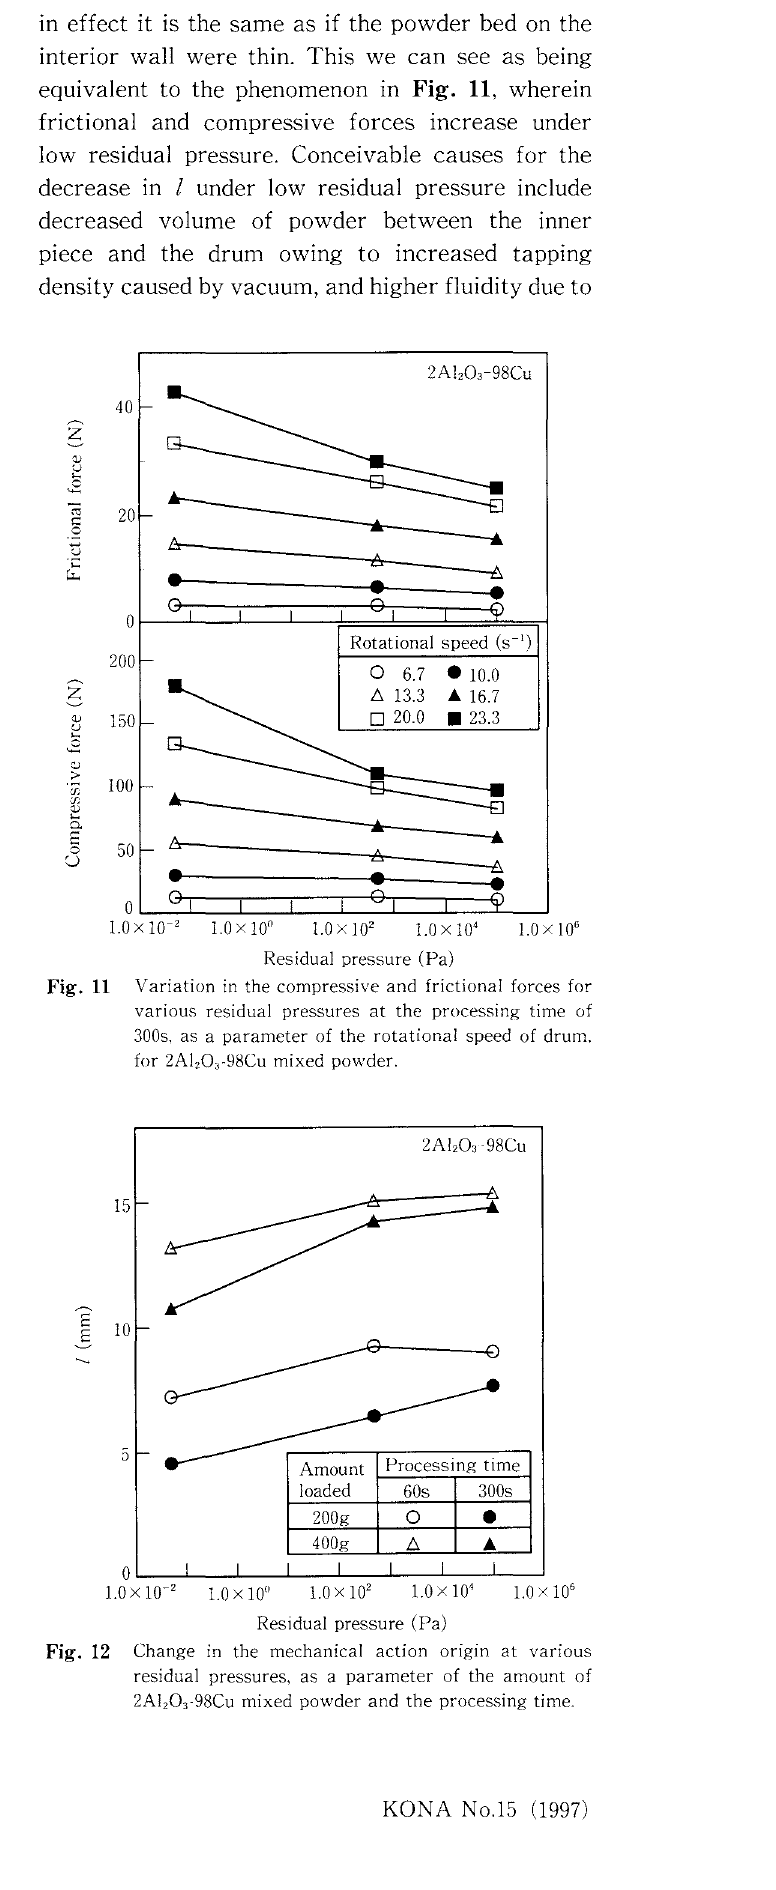
Fig. 12 Change in the mechanical action origin at various residual pressures, as a parameter of the amount of 2AI,0,-98Cu mixed powder and the processing